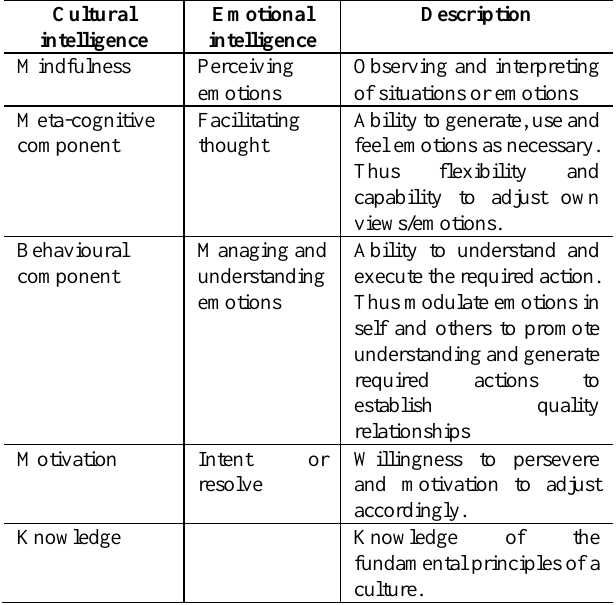
Table 3: Summary of the link between cultural and emotional